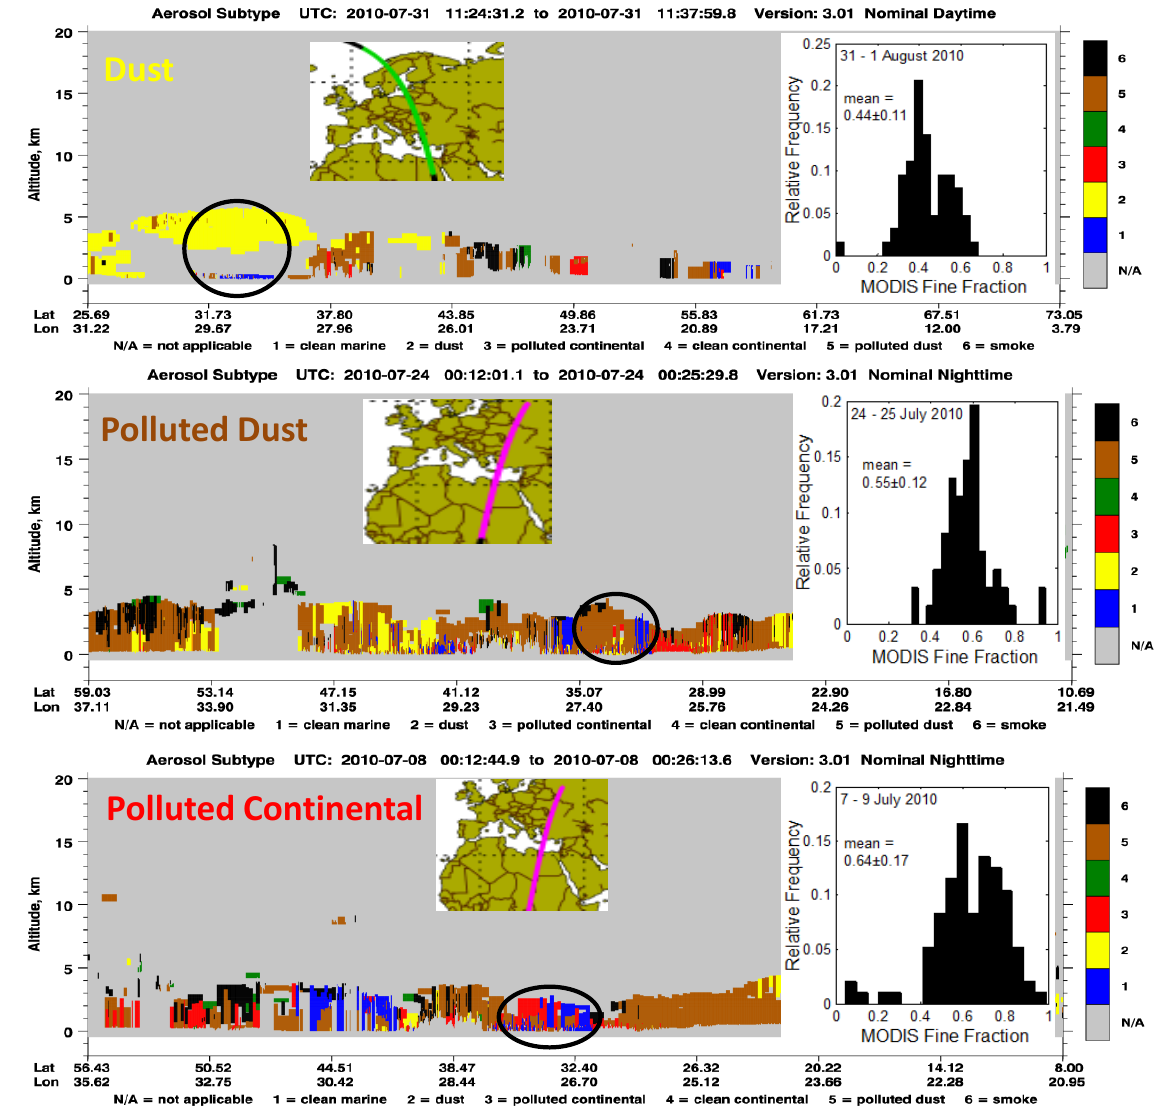
Figure 9. Assessment of CALIOP-derived aerosol classification (vertical feature mask: VFM) using MODIS fine fraction (ff) in three different cases of dust, polluted dust and polluted continental over the ROI. The relative frequency histogram of ff for each case is calculated over the ROI. Approximated latitudinal extent of ROI is shown by black circles for each case in VFM figure. The various colors of VFM represent different dominant aerosol types which are marked as integer number (1–6) in respective plots. The connotations of integer numbers are given at the bottom of each plot. The marine aerosols (blue color) are present in all three